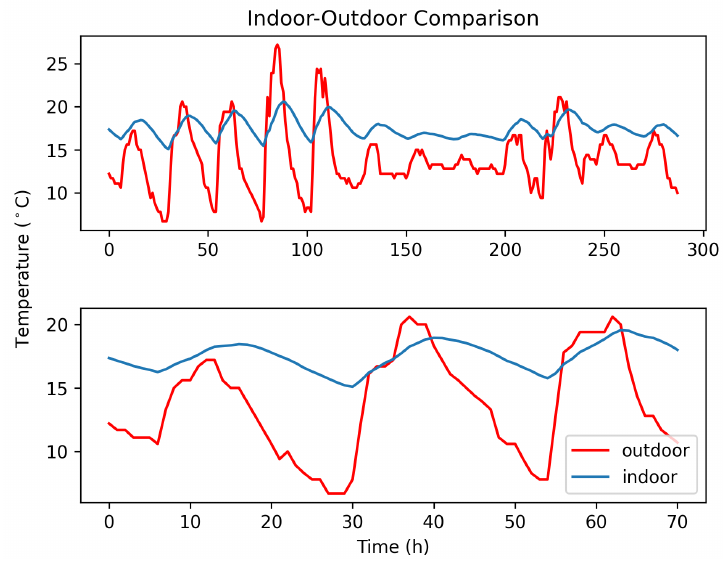
Figure 4. Indoor-outdoor temperature closeup of a 72 h window within the data